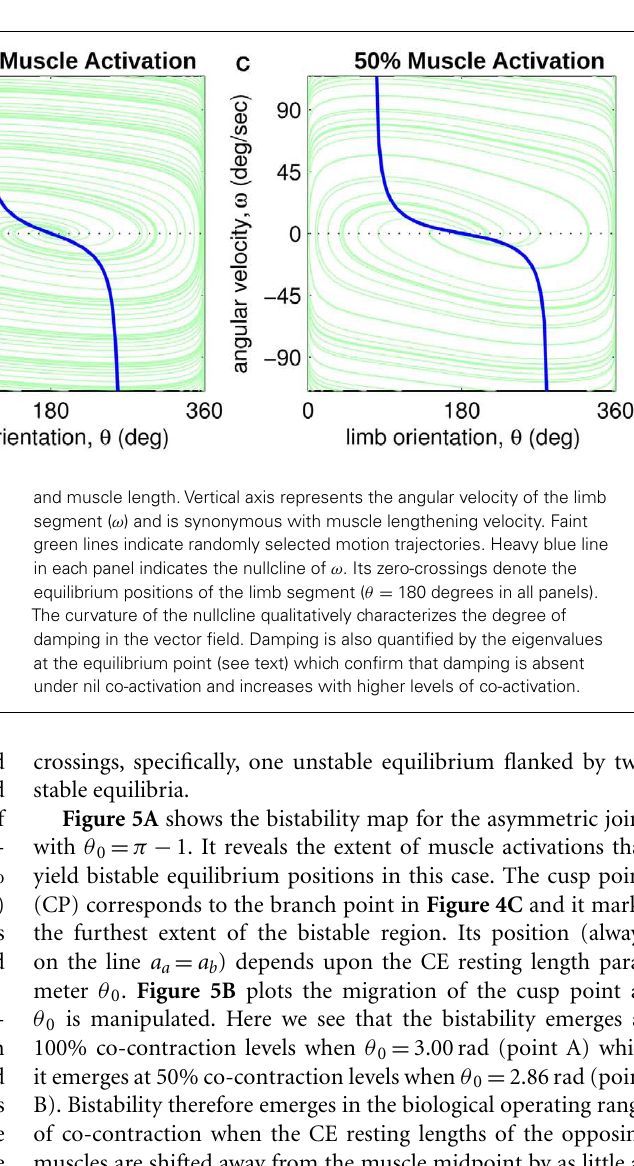
and muscle length.Vertical axis represents the angular velocity of the limb segment ( ω ) and is synonymous with muscle lengthening velocity. Faint green lines indicate randomly selected motion trajectories. Heavy blue line in each panel indicates the nullcline of ω . Its zero-crossings denote the equilibrium positions of the limb segment ( θ = 180 degrees in all panels). The curvature of the nullcline qualitatively characterizes the degree of damping in the vector field. Damping is also quantified by the eigenvalues at the equilibrium point (see text) which confirm that damping is absent under nil co-activation and increases with higher levels of